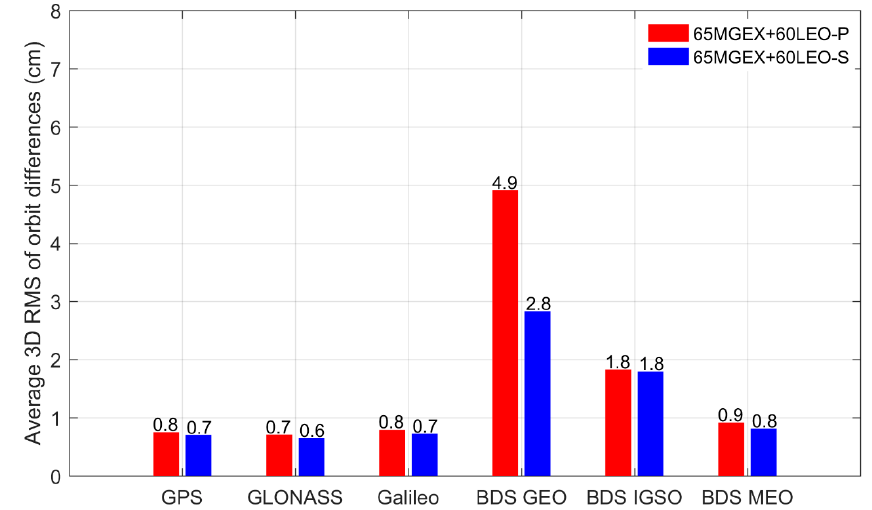
Figure 7. Average 3D orbit differences RMS of GNSS satellites for the integrated POD with different orbit types of LEO satellites. Values on the top of each bar indicate the corresponding average 3D RMS. P and S denote the nearly-polar and sun-synchronous orbits, respectively. orbiting constellation in terms of the convergence time of PPP. However, the situation is reversed